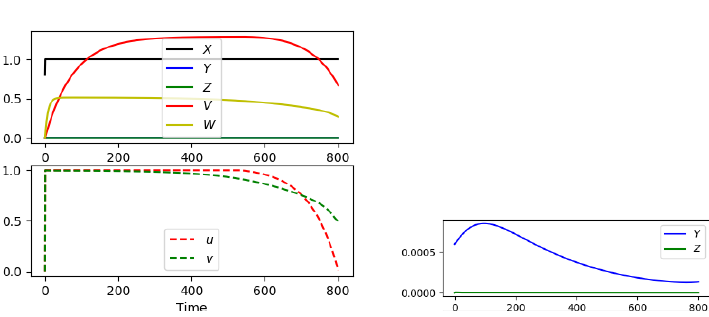
Figure 4. Numerical Optimal Control and Treatment Simulation Results - Low Anti-Angiogenic Side Effect